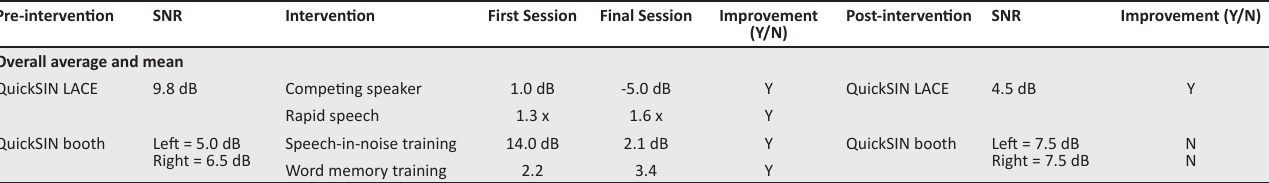
TABLE 4: Assessment and intervention results (mean).